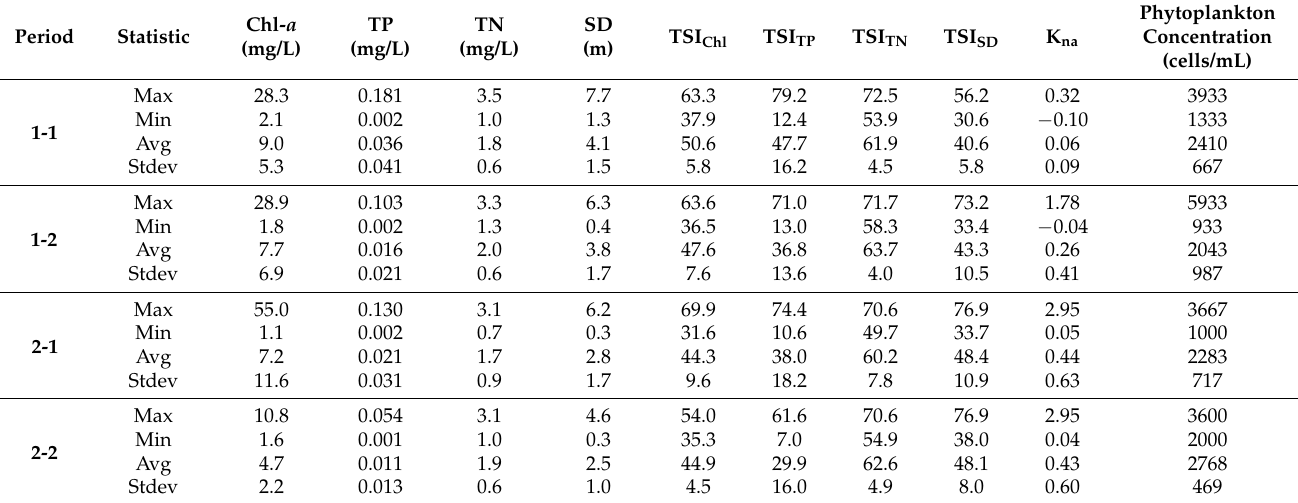
Table 1. Summary of statistics of measured water quality parameters and calculated trophic state indices. Period